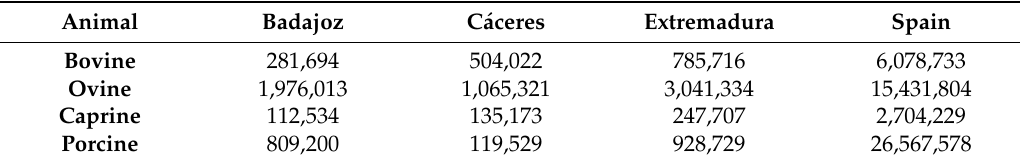
Table 3. Animals census by species, 2014 [19].